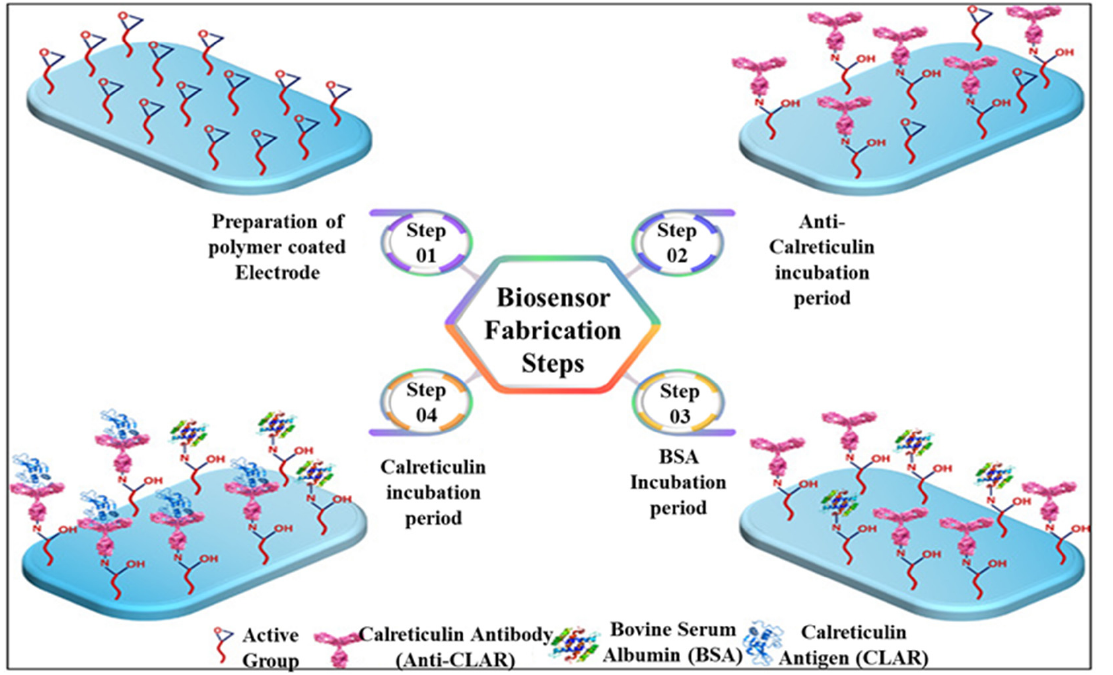
Figure 7. Schematic of the label-free immunosensor for CALR construction process with disposable